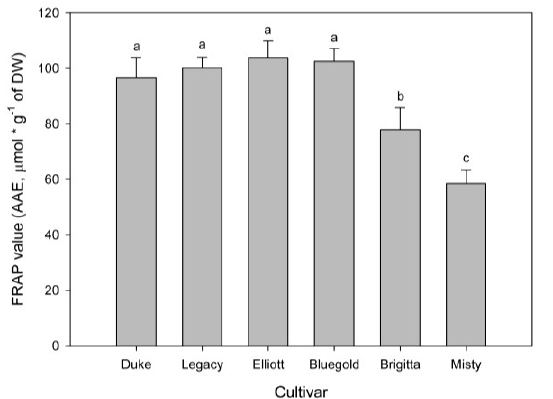
Figure 3. Antioxidant power measured by the Ferric reducing antioxidant power (FRAP) method for six in vitro highbush blueberry cultivars. Each bar corresponds at the mean of nine independent measurements ± standard error; letters represent significant differences ( p <